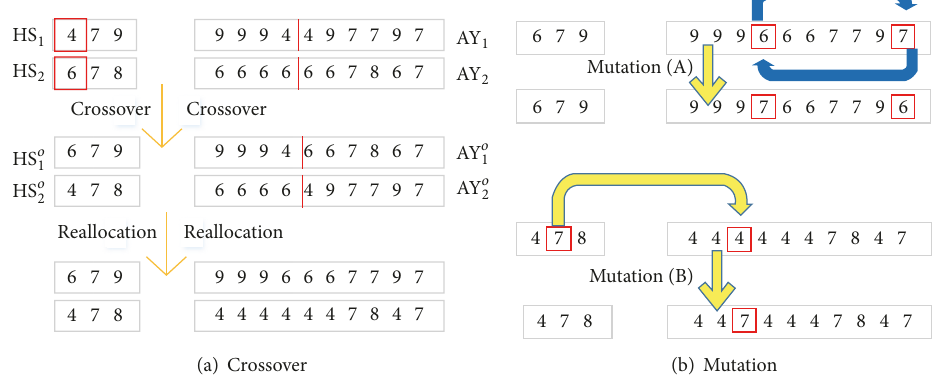
Figure 3: A small example of crossover and mutation. Hubs are encoded by numbers: (a) Hubs 4 and 6 are swapped between two hub arrays. The assignments of the nodes after the red lines are also swapped between two assignment arrays. After the reallocation, the offspring individuals are generated. (b) The assignments of two spokes are exchanged in the first mutation; a random spoke is reassigned to a random hub in the second